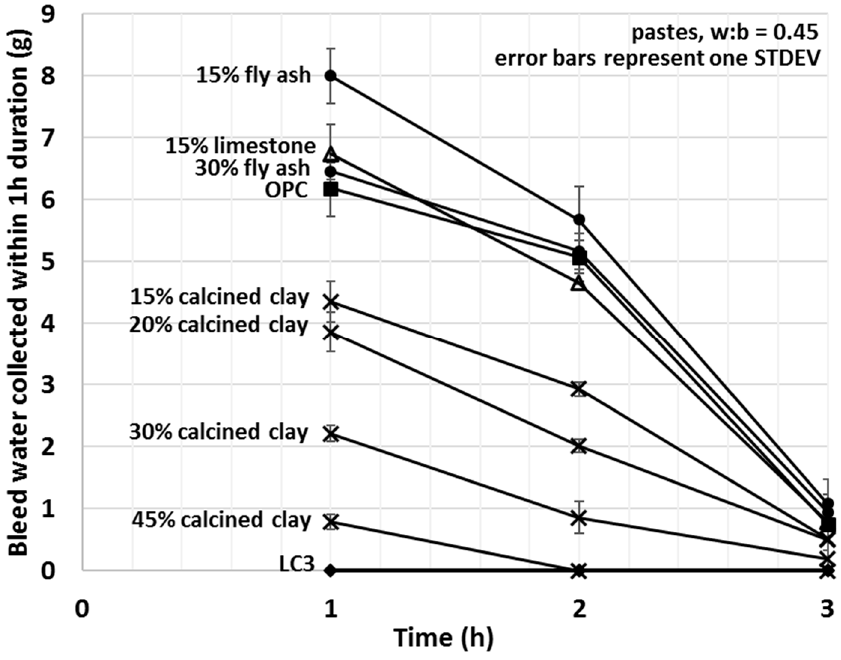
Figure 6. Average mini bleed values of OPC, limestone, LC3 and various fly ash and calcined clay blends after one, two and three hours (each data point corresponds to a 60 min bleeding period, the curves are non-cumulative).